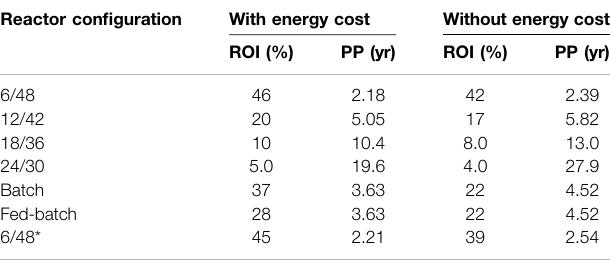
TABLE 5 | Financial analysis of demonstration-scale con fi gurations. Reactor con fi guration With energy cost